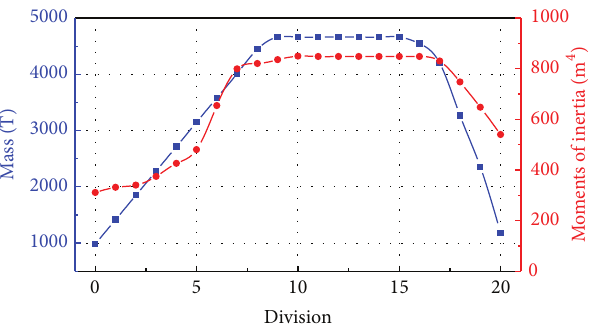
Figure 4: Distributions of mass and vertical moment of inertia.